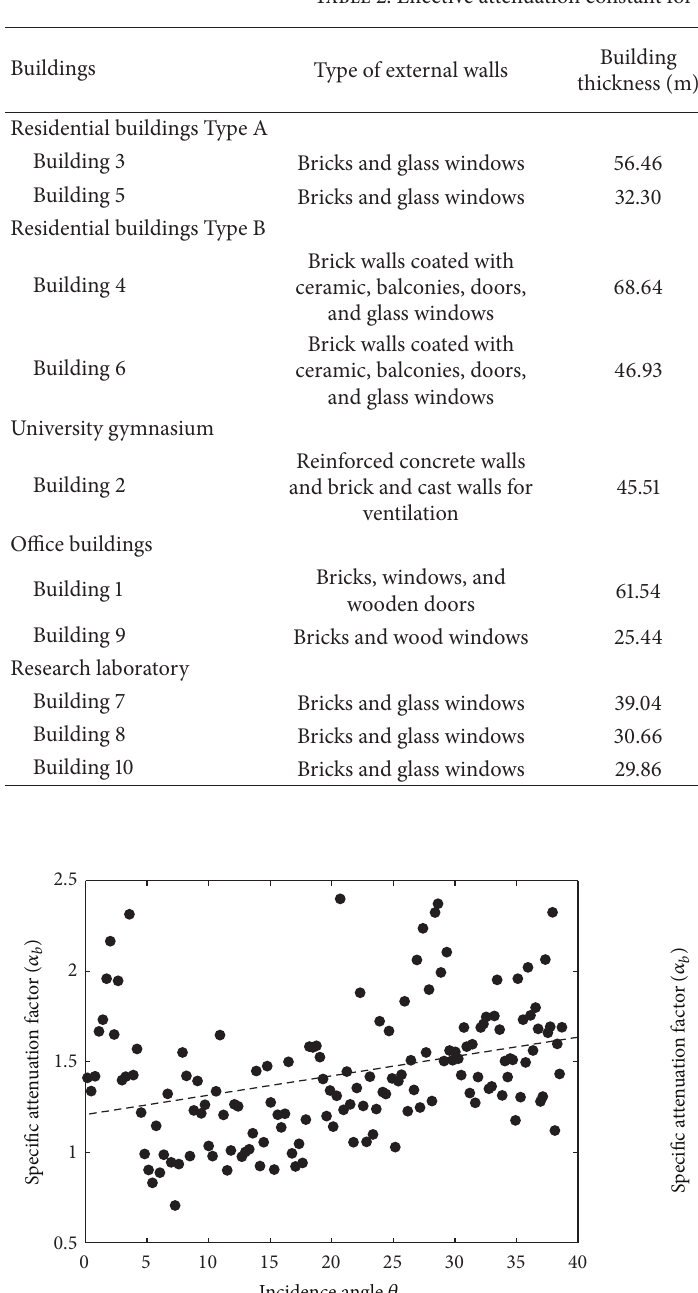
Table 2: Effective attenuation constant for different types of buildings.